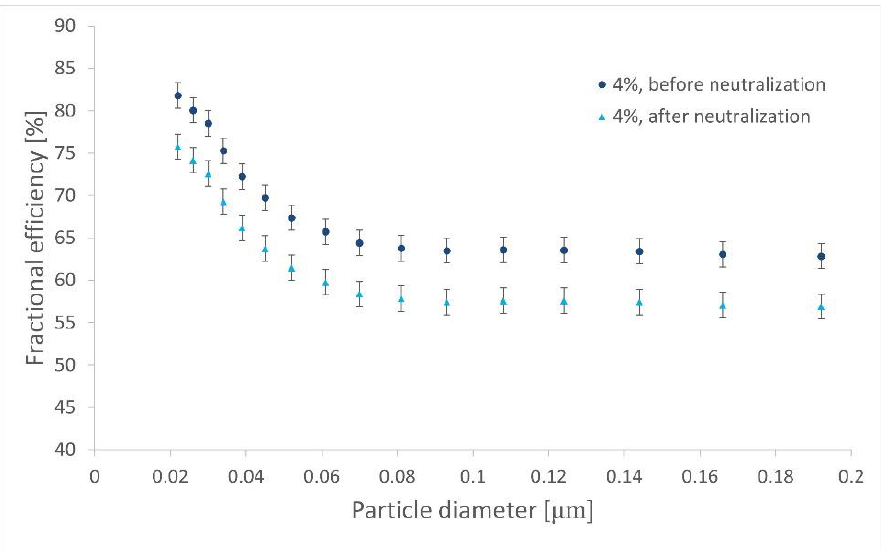
Figure 13. Fractional efficiency of material made from 4% solution, before and after neutralization.